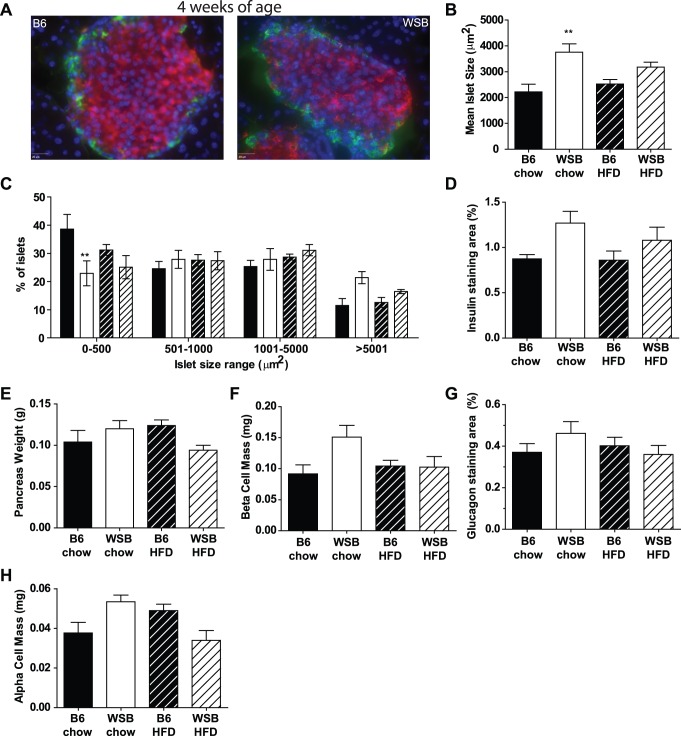
Islet structure and size, β-cell mass, and α-cell mass in young WSB mice.Studies were performed on mice at 4 weeks of age. A. Representative islets from B6 (left) and WSB (right) mice. Insulin (red), glucagon (green) and DNA (blue) are stained. B. Mean islet sizes (average number of islets per mouse examined: B6 chow- 166, B6 HFD 130, WSB chow 108, WSB HFD 115). C. Islet size distribution of B6 (black; chow solid, high fat diet (HFD) striped) and WSB (white; chow solid, high fat diet white striped) mice. The range of islet sizes observed was similar in all groups. D. Percent of pancreatic area stained for insulin. E. Pancreas weight for stained tissues. F. β-cell mass. G. Percent of pancreatic area stained for glucagon. H. α-cell mass. (n = 5 mice per strain per diet). **p<0.01 vs. B6 mice consuming the same diet.